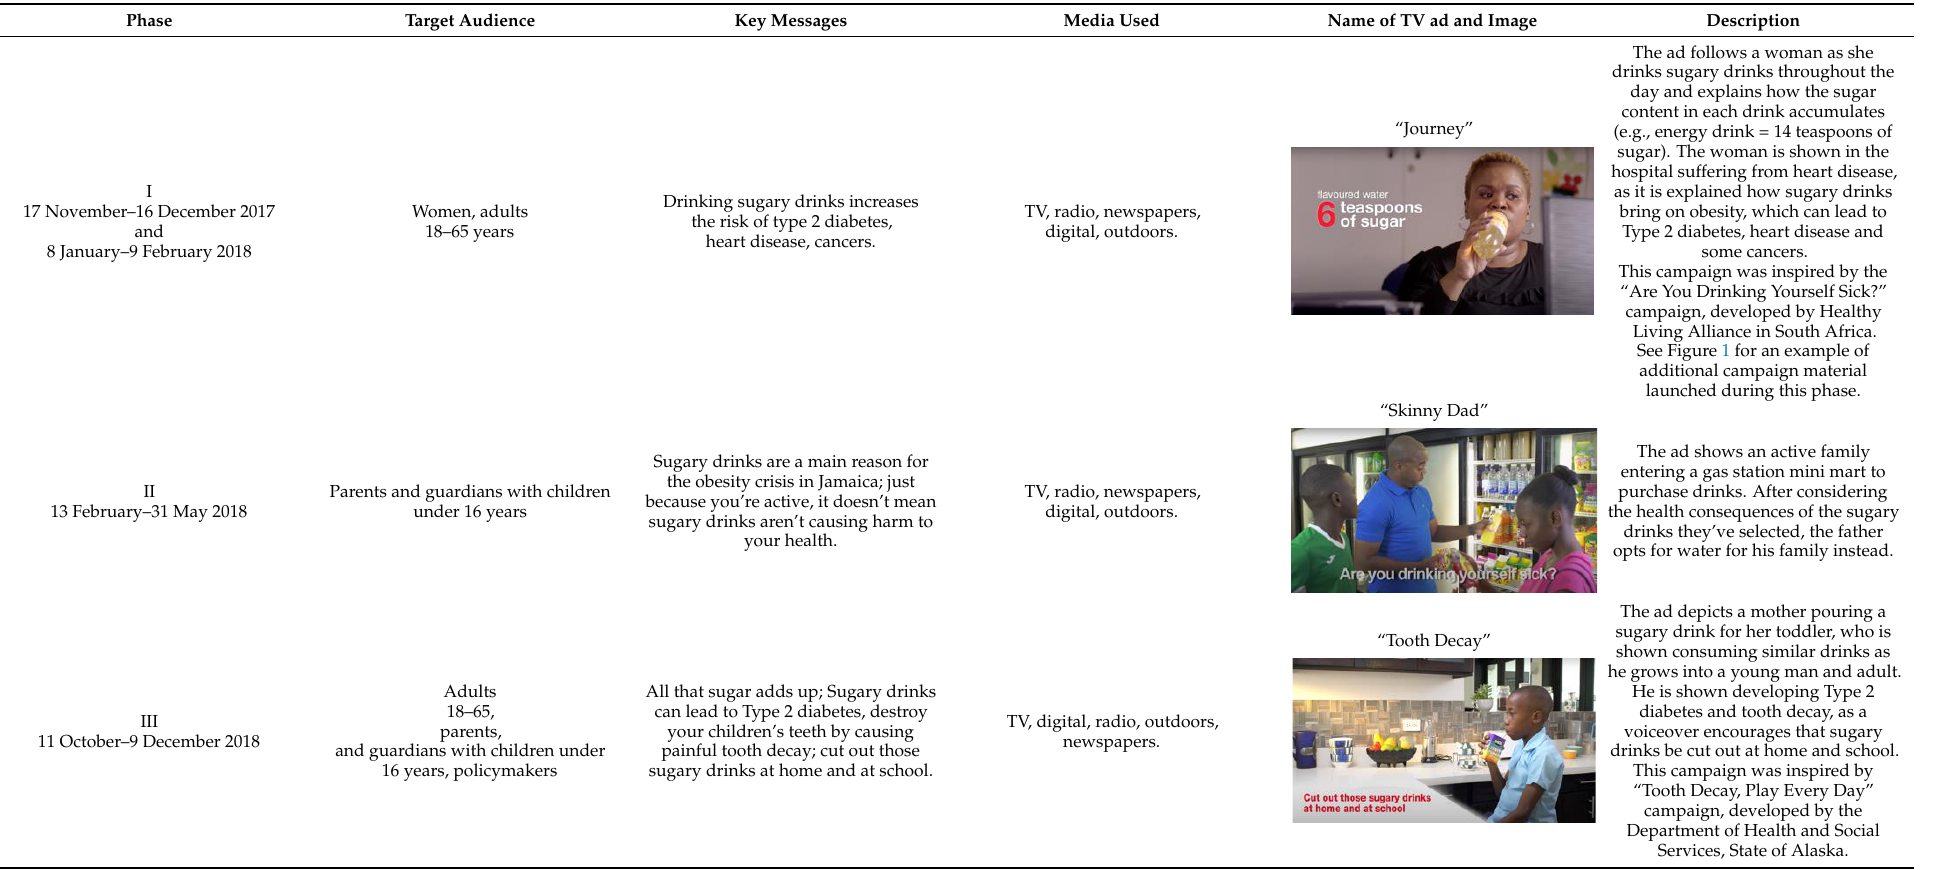
Table 1. Campaign details with key messages.